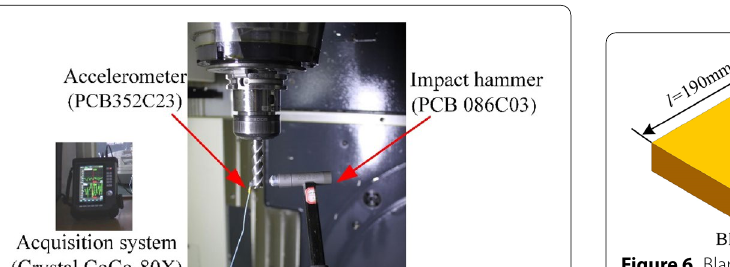
Figure 5 Dynamics testing of machine tool